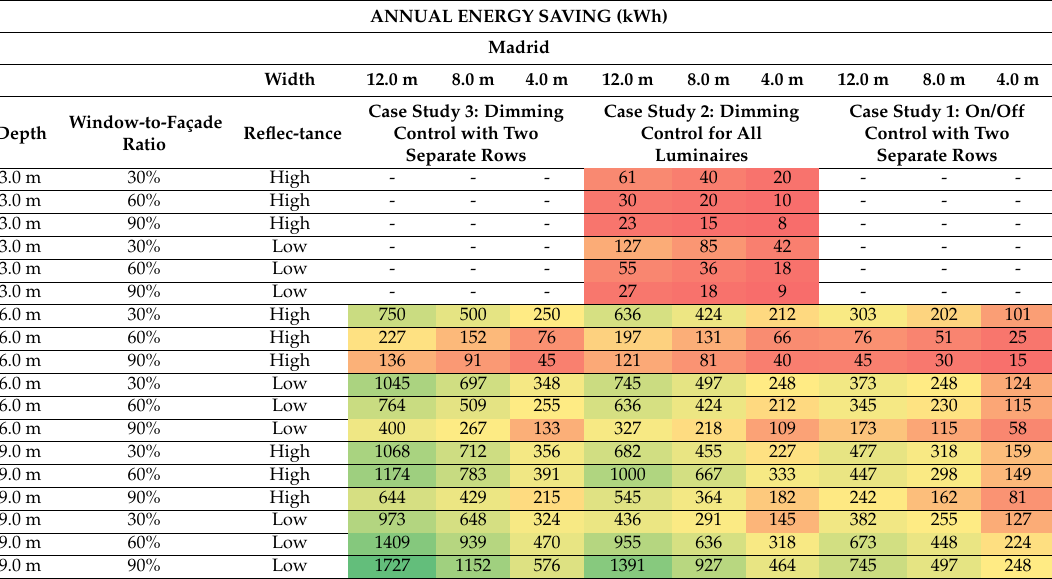
Table 11. Annual energy saving in kWh of different lighting smart controls in